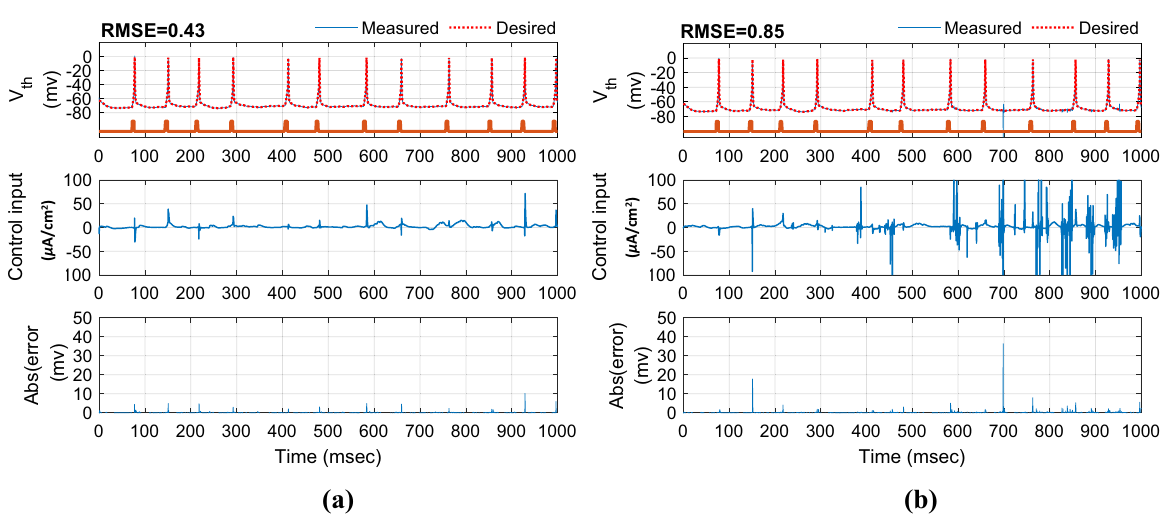
Figure 9. Typical results of the closed-loop control for neuron 1 under 50% time-varying system parameters and external disturbances using ( a ) AFTSMC ( b )